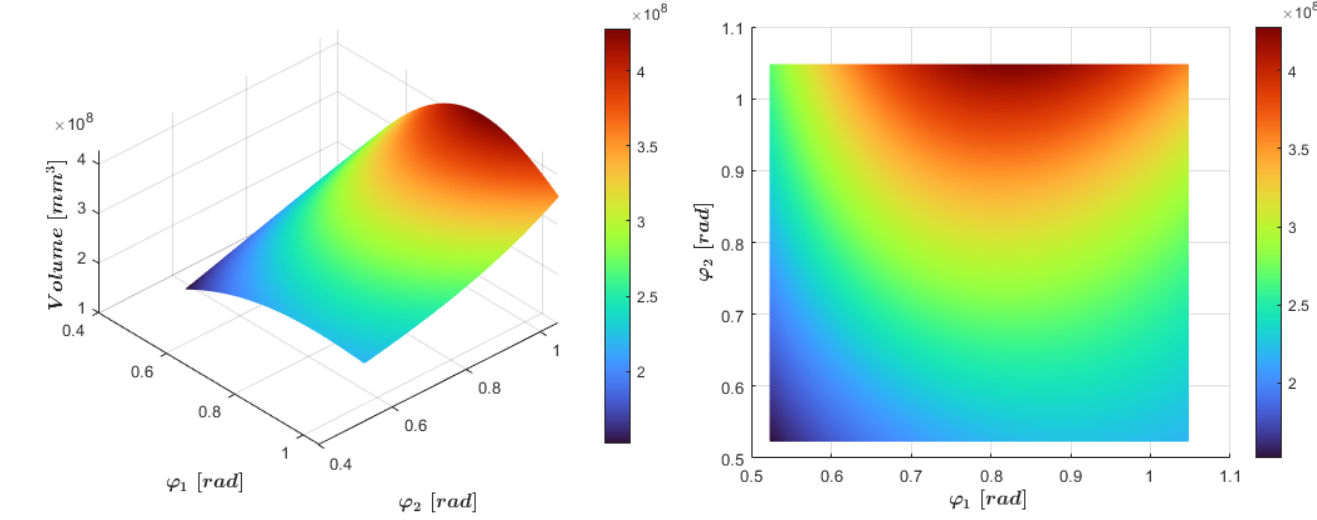
Figure 9. Representation of the volume distribution based on the values of tilt angles 𝜑 (cid:2869) and 𝜑 (cid:2870) . It was observed that the volume tends to be at its maximum around 𝜑 (cid:2869) = 47,15° and 𝜑 (cid:2870) is the maximal value of the interval of the analysis, which, in this case, is